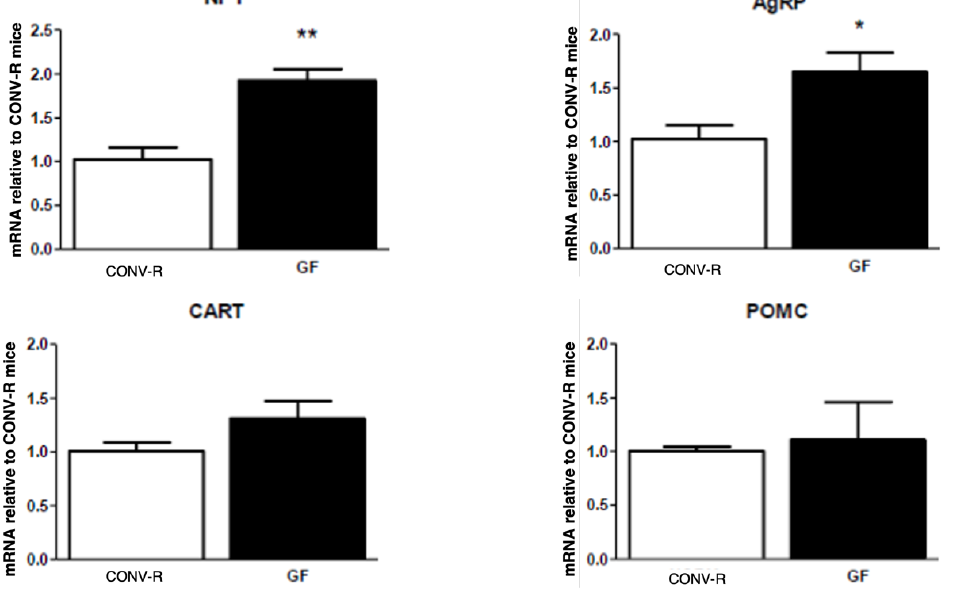
Figure 3. mRNA expression of NPY, AgRP, POMC, and CART in the hypothalamus of GF and CONV-R mice after a 5-h fast. mRNA expression of GF mice is relative to the mean level of their CONV-R counterparts. Data are expressed as means ± SEM. * denotes statistical difference between GF and CONV-R, * p < 0.05, ** p < 0.01.